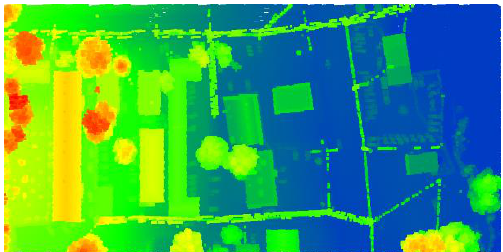
Figure 6. The testing area for 3D straight line segment